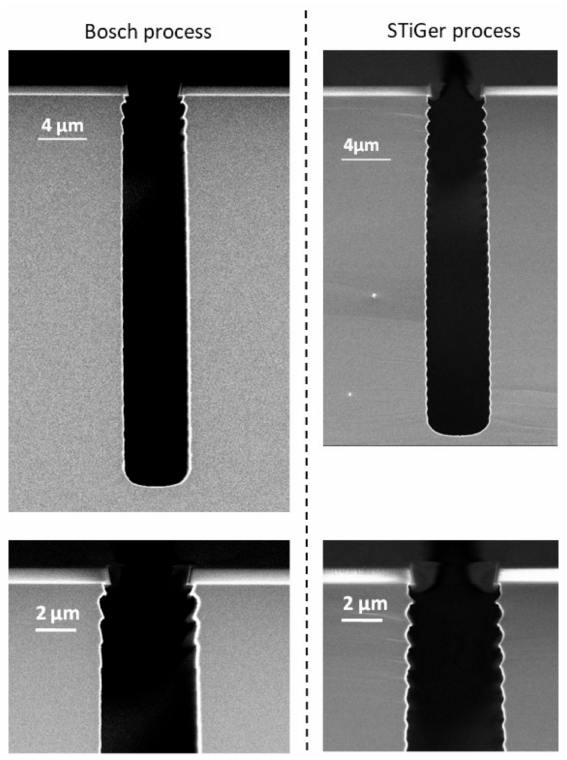
Figure 3. SEM cross-section views of 4 µ m trenches etched with the Bosch process ( left ) and the STiGer processes ( right ) using plasmas parameters given in Table 1. Table 2. Measurements on trench profiles displayed in Figure 3 and etched with the STiGer and the Bosch processes, Alcatel 601E ICP